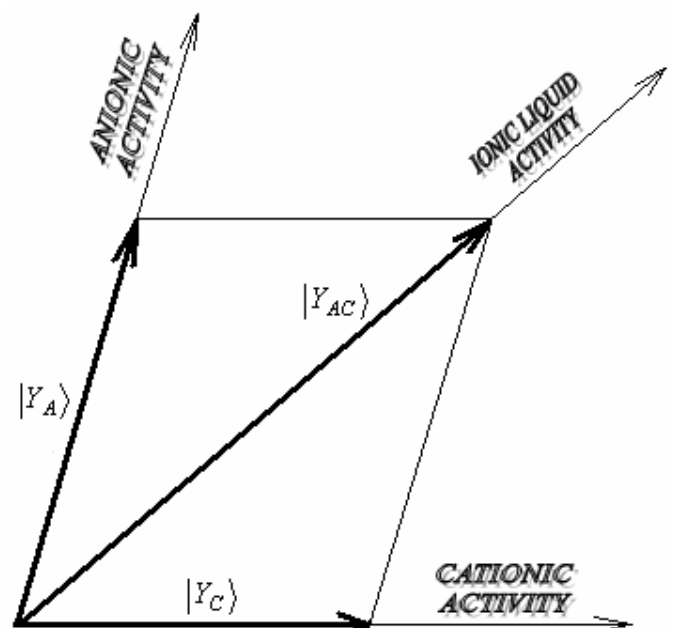
Figure 1: The vectorial summation of the cationic and anionic activities in ionic